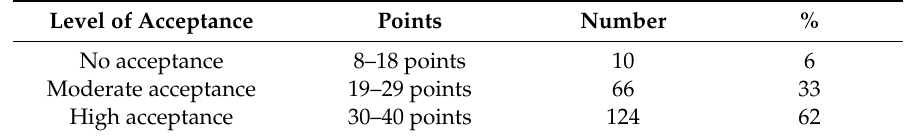
Table 2. Division of the study population into groups according to the level of acceptance of their illness.